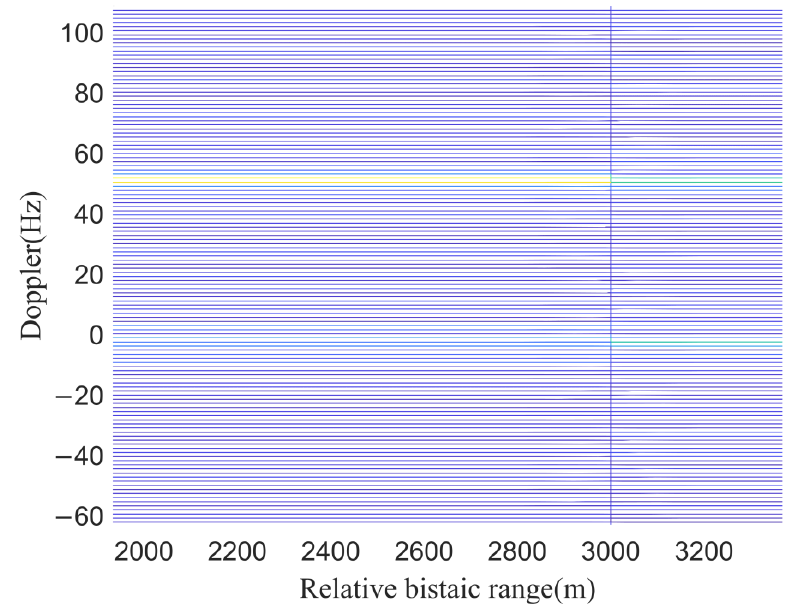
Figure 22. Zoomed in near 0 Doppler.